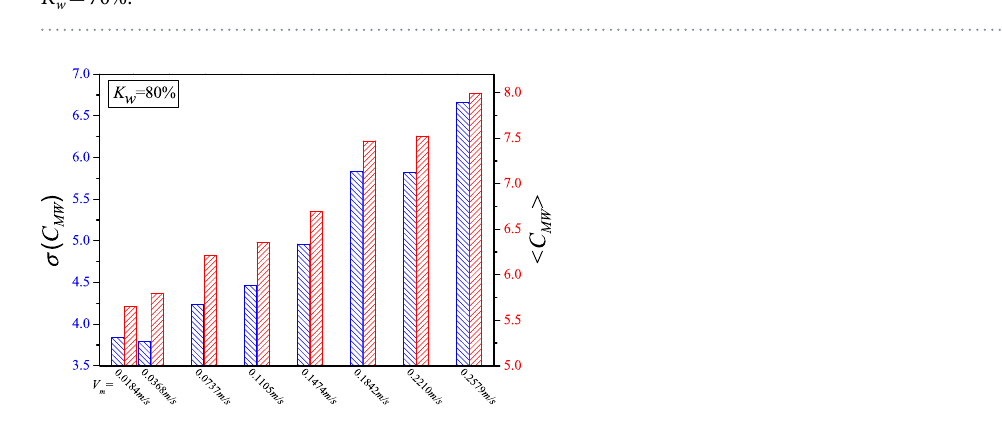
Figure 6. < C MW > and σ ( C MW ) for flow conditions with different total flow velocities ( V m ) when water-cut K w = 70%.